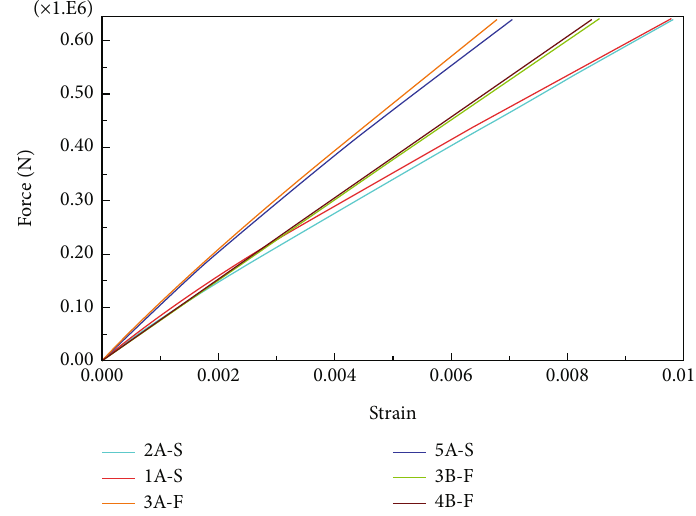
Figure 10: Standard analysis load-strain progression.